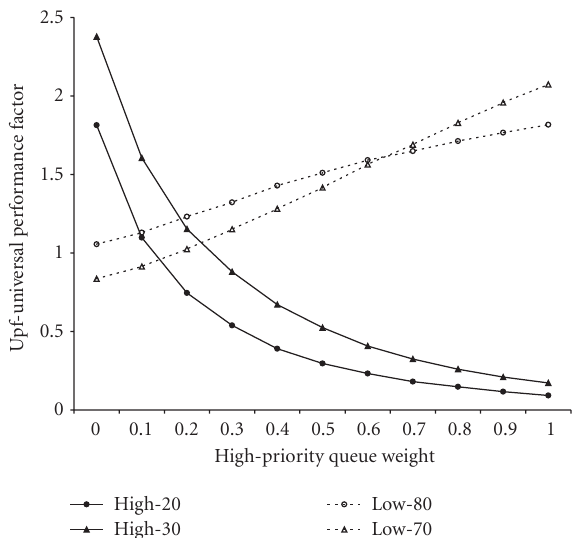
Figure 10: Normalized delay for di ff erent priority classes under varying high-priority queue weights and high